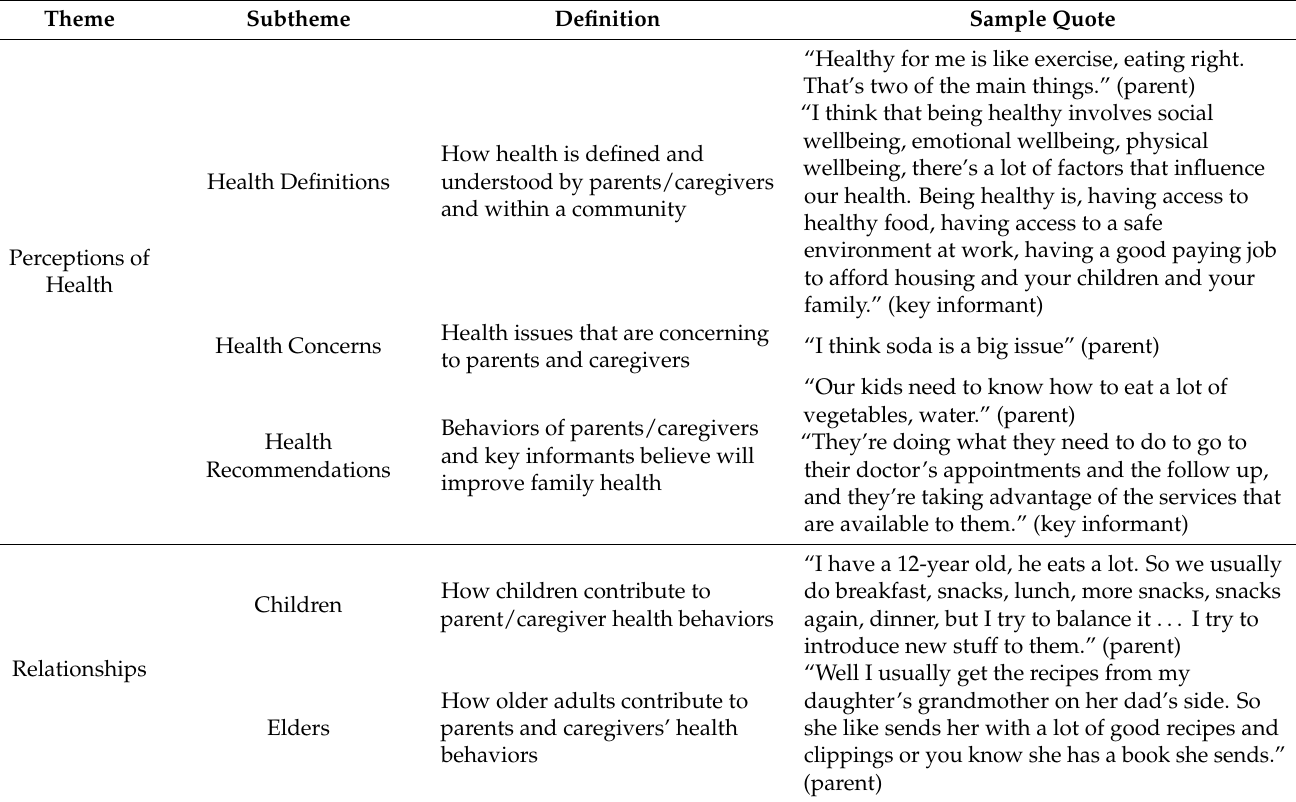
Table 4. Key informant and parent focus group themes, subthemes, and representative